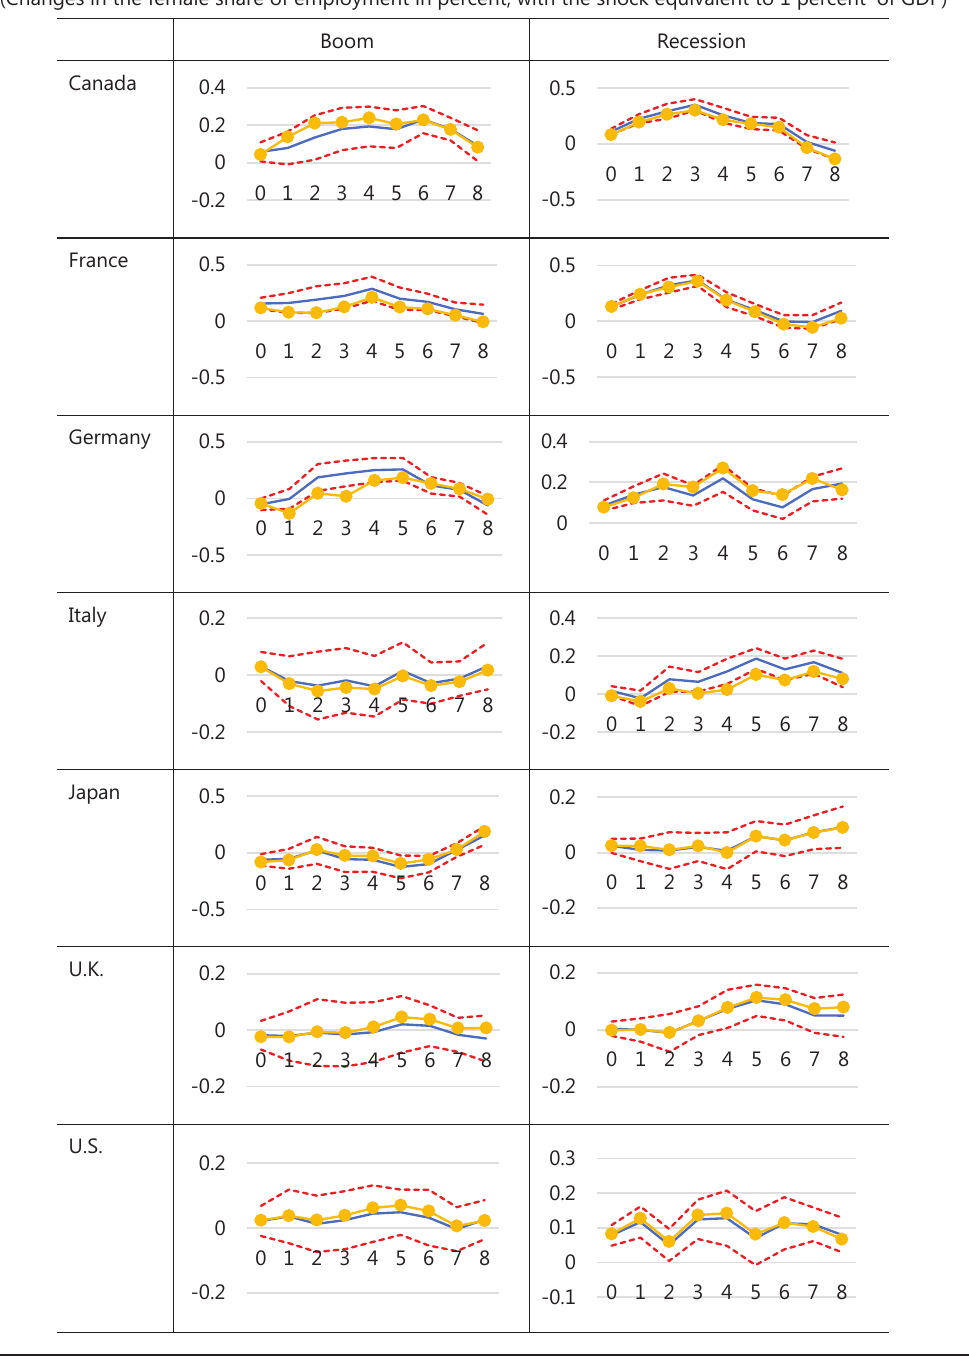
Note : Dashed lines indicate 95 percent confidence intervals and lines with circles present impluse reponses functions in the baseline